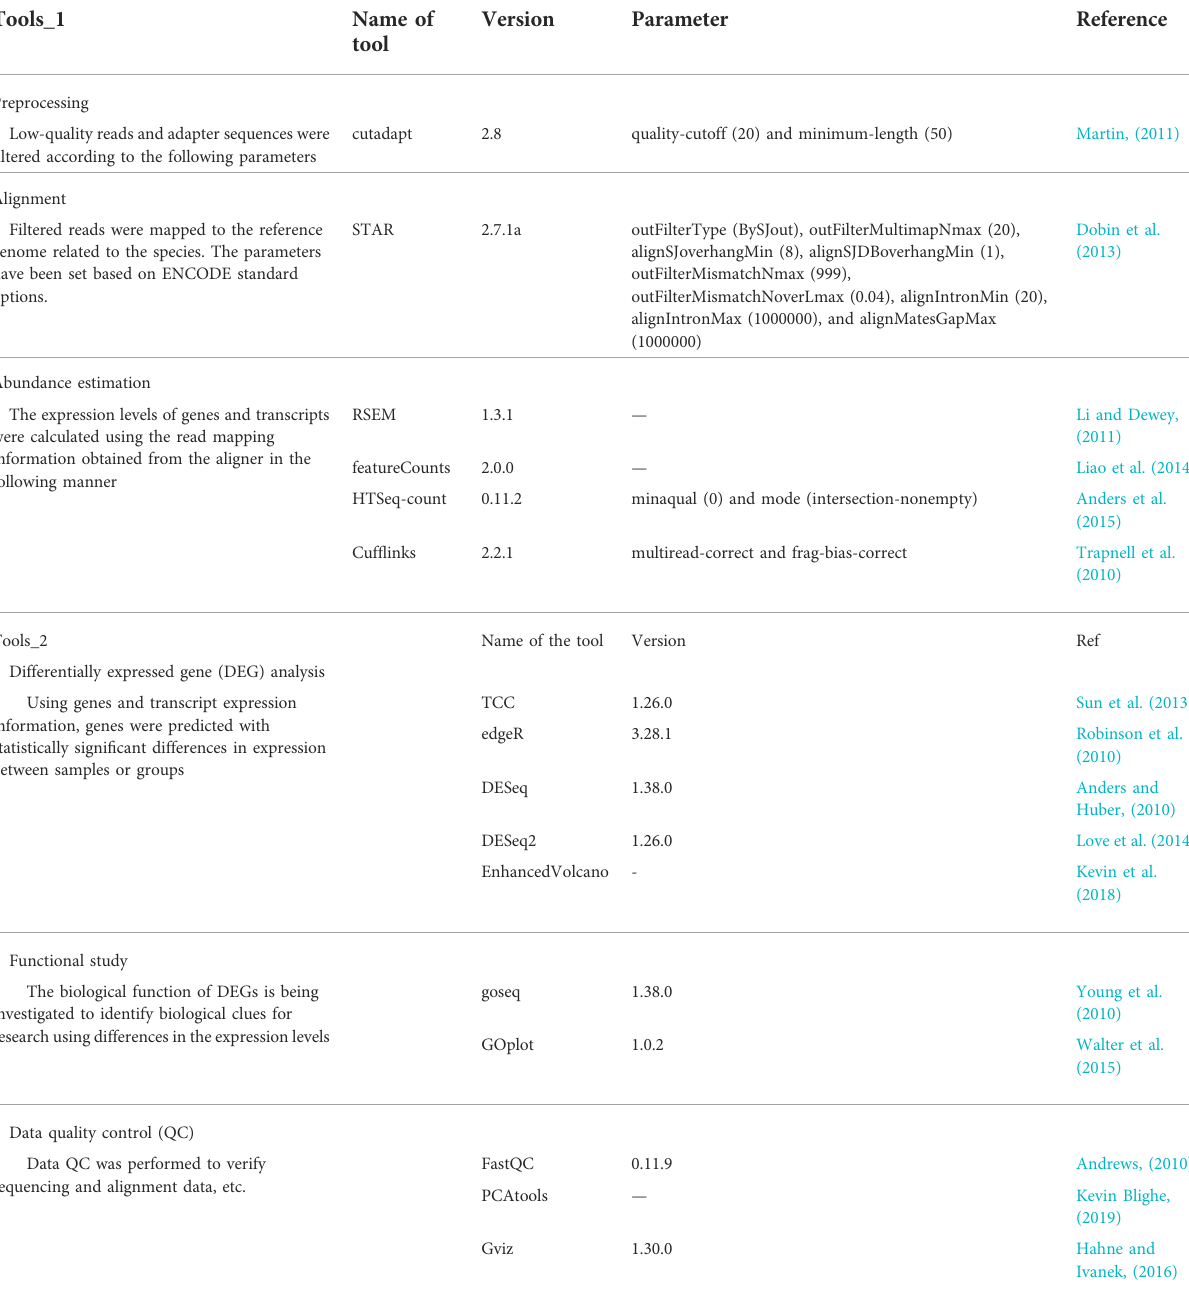
TABLE 4 Tools and